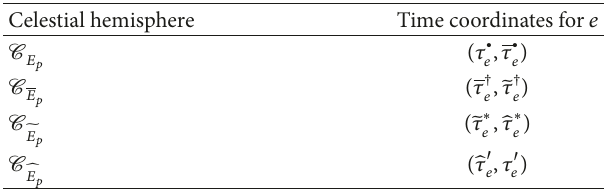
Table 11: The pairs of time coordinates for 𝑒 deduced in the four celestial